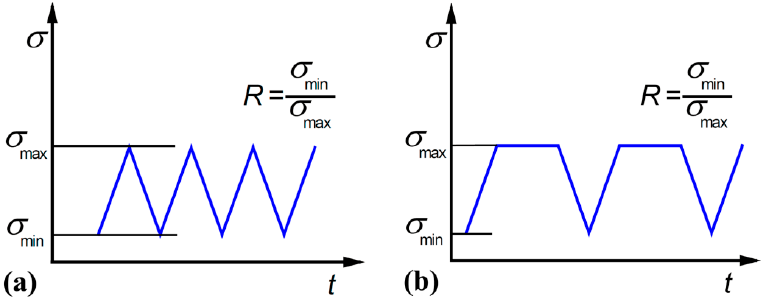
Figure 3. ( a ) Schematic of loading waveforms for conventional fatigue test; ( b ) schematic of loading waveforms for dwell fatigue test.